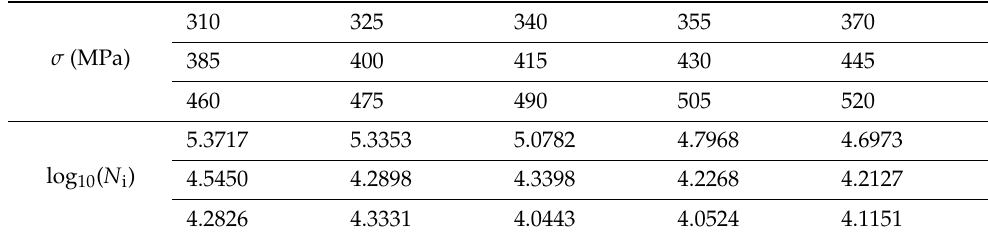
Table 1. Simulated samples generated from the known P-S-N